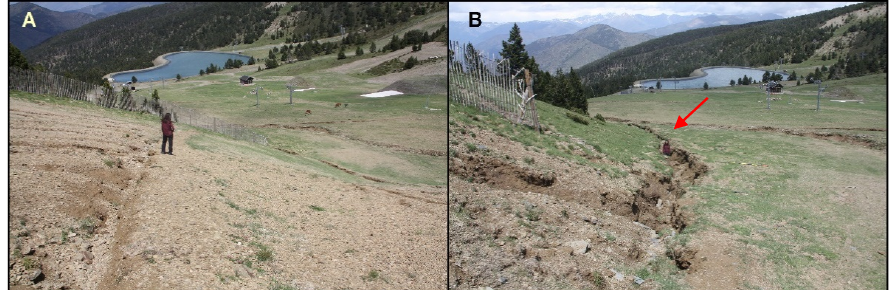
Figure 10. Pictures of the erosion on the basin headwaters due to land-use changes and enhanced by drainage water channels and concentration of runo ff . ( A ) drainage water artificial channel and ( B ) gully erosion downstream; for a better appreciation of the scale, note the person in the channel highlighted with a red